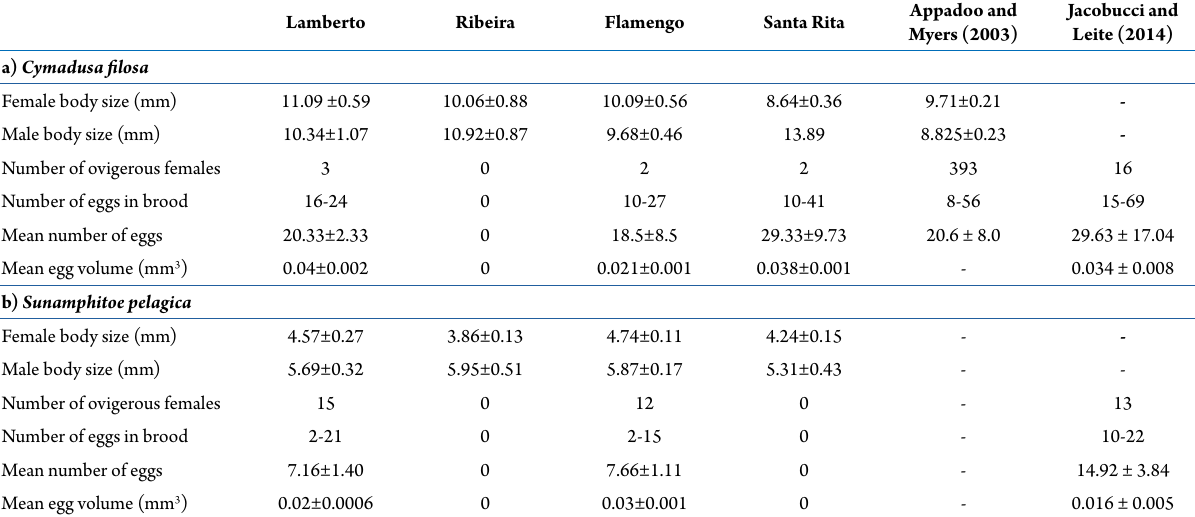
Table 7. Summary of biological characteristics for both species, Cymadusa filosa and Sunamphitoe pelagica , at each site in this study (Lamberto, Ribeira, Flamengo and Santa Rita) and in other studies elsewhere (Appadoo and Myers, 2004; Jacobucci and Leite, 2006). “–” = Absence of reference